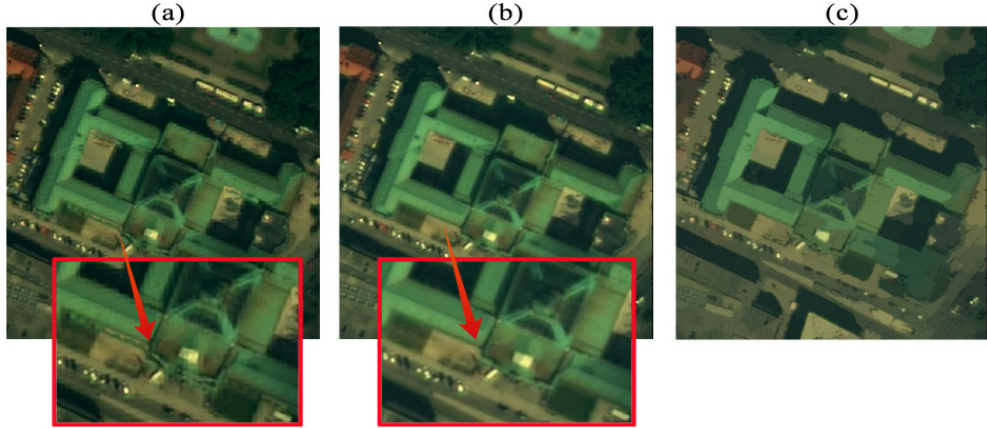
Figure 8. Artifacts around building boundaries in the orthorectified image ( a ), made us use the un-orthorectified image ( b ). ( c ) shows the result of ESLIC superpixel segmentation on the image ( b